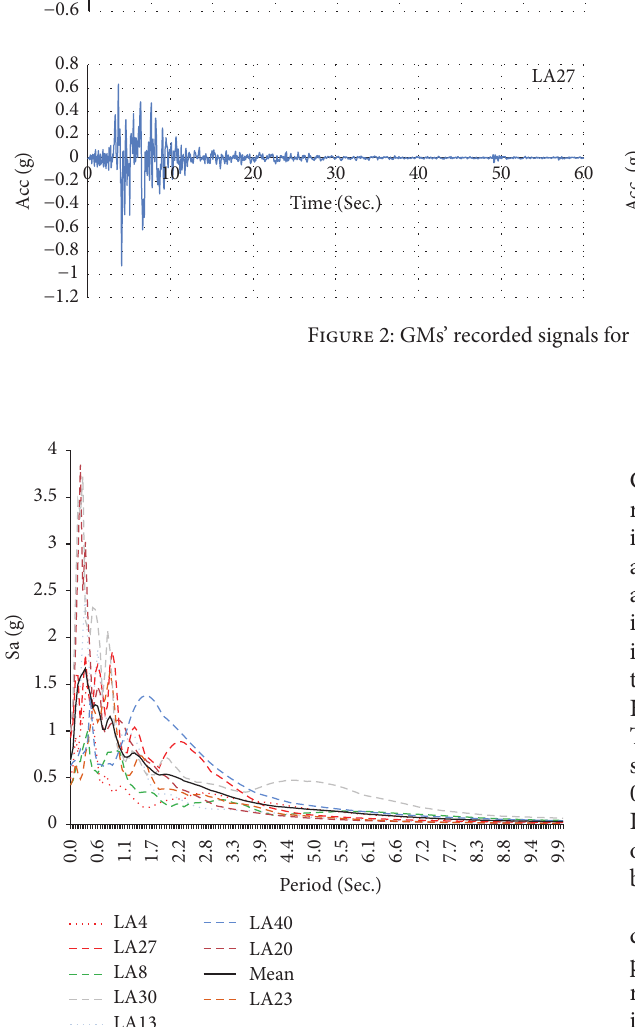
Figure 3: Acceleration response spectrum for the selection of GMs’